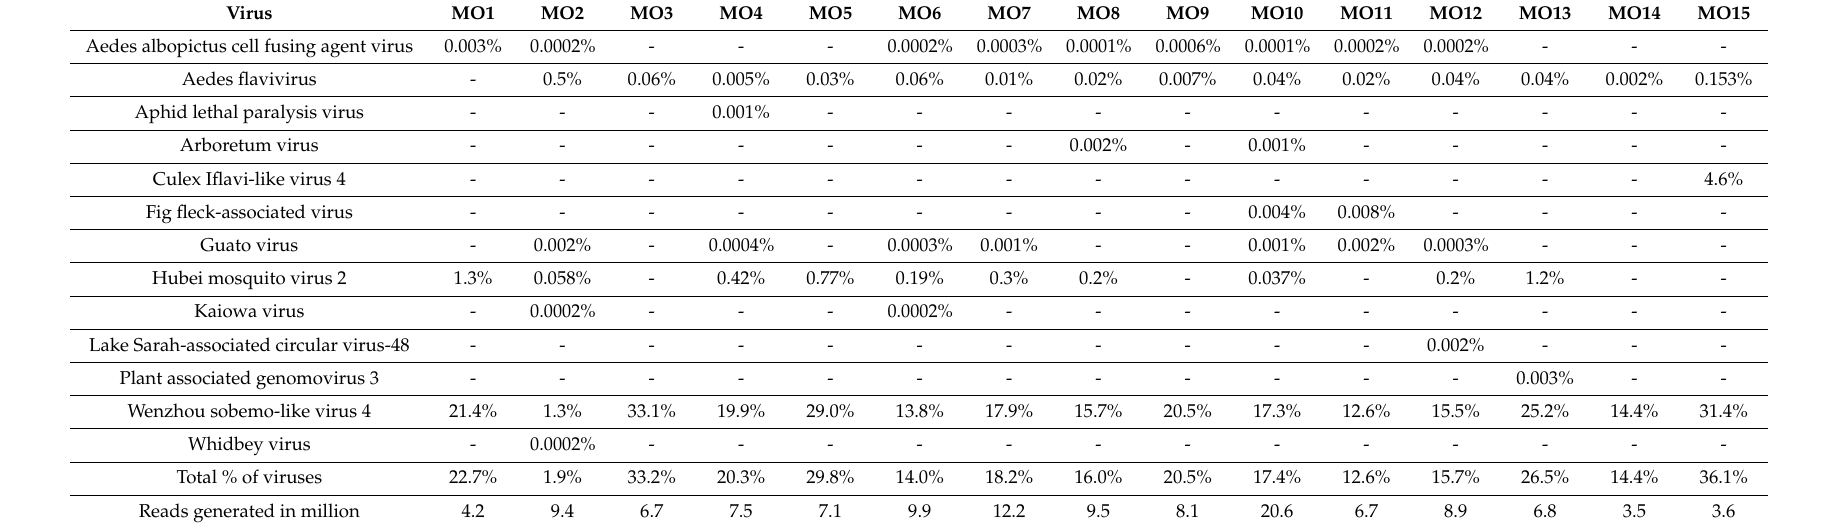
Table 2. Viral reads detected shown as a percentage of the total number of reads generated from each pool of